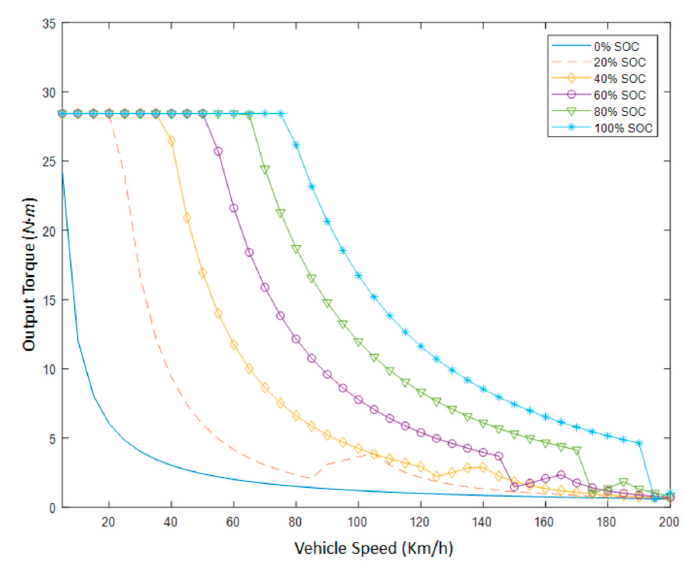
Figure 13. PS-FHV speed-torque curve versus vehicle speed and FESS SOC status.